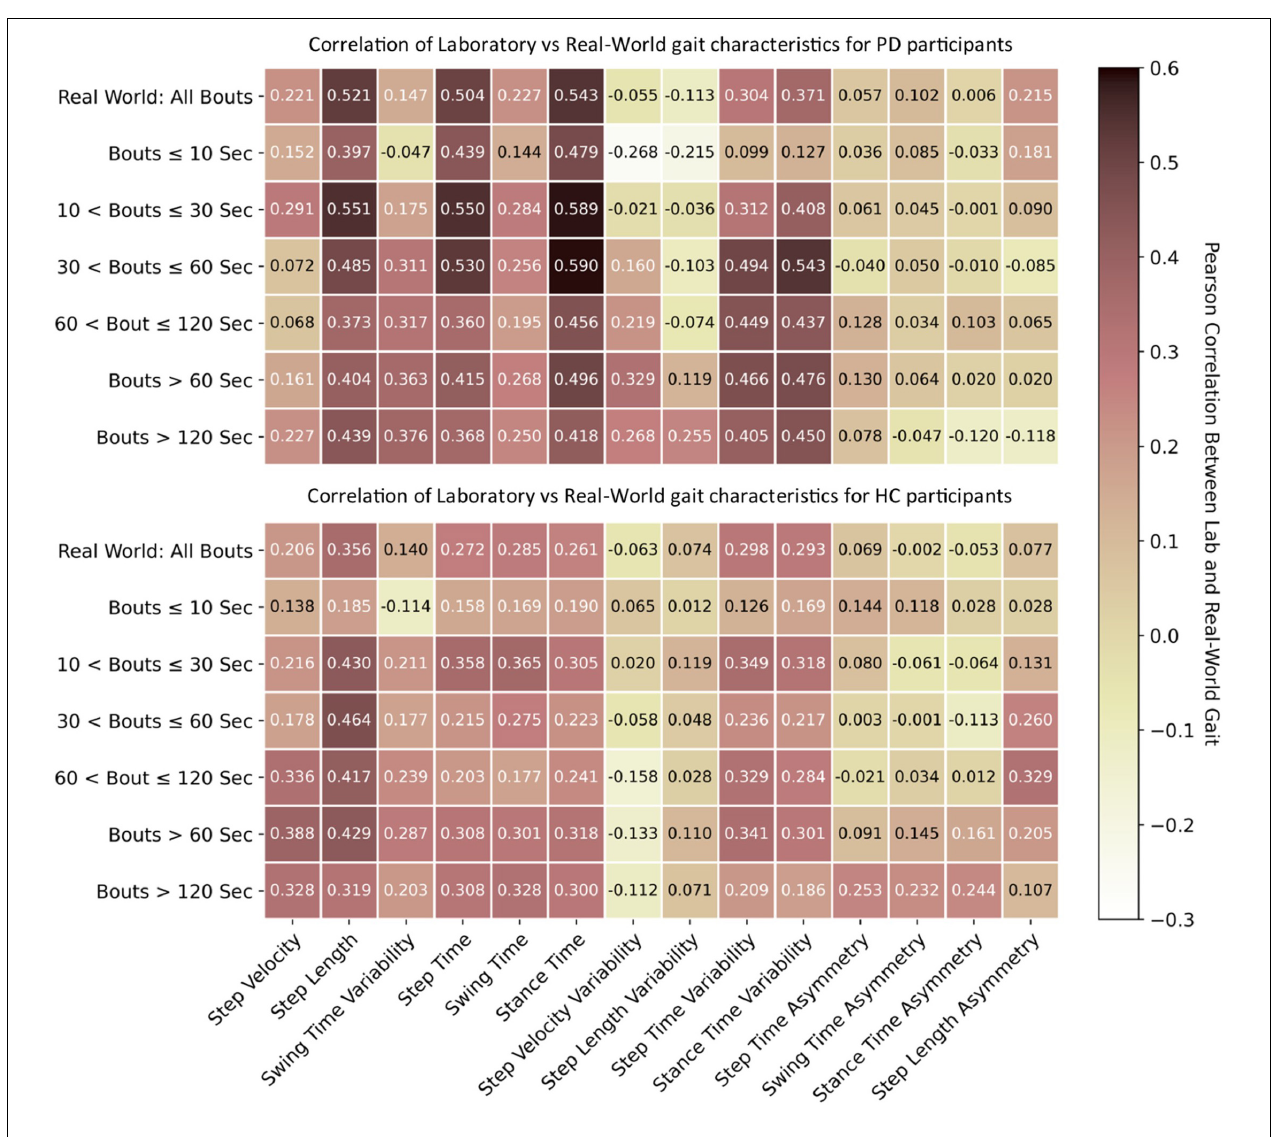
FIGURE 5 | Association between lab-based gait characteristics with real-world gait. Pearson’s correlation r values for both PD and HC.